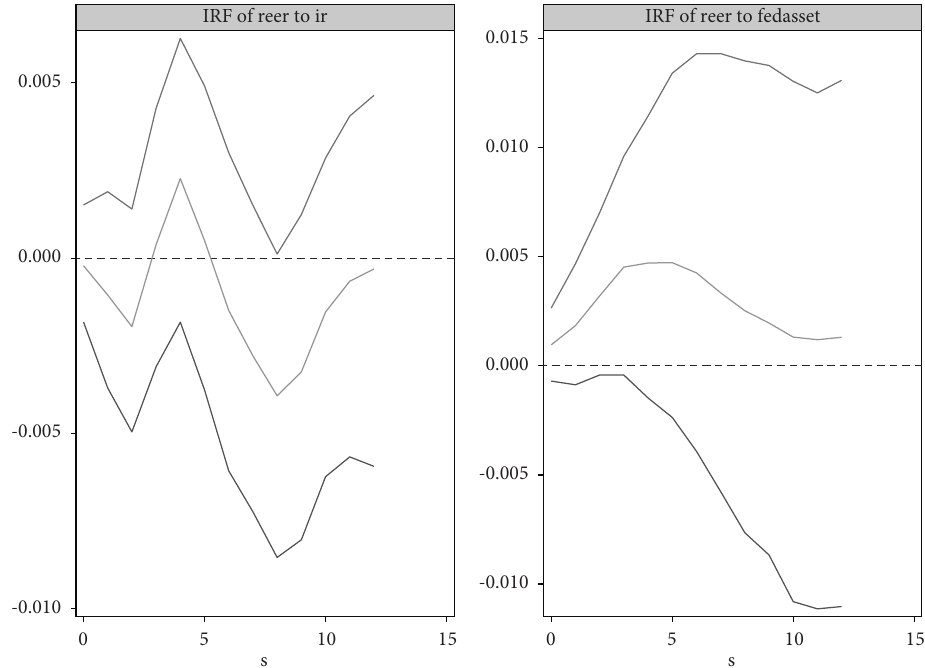
Figure 4: Impulse responses of REER to U.S. monetary policy shock in BRICS countries.